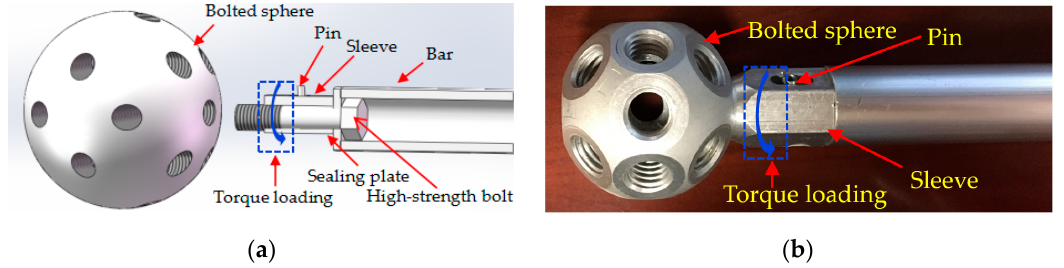
Figure 4. ( a ) Installation schematic representation of bolted spherical joint ( b ) Photo of bolted spherical joint